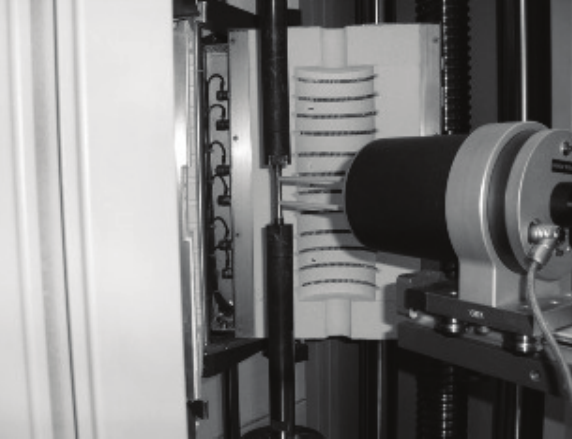
Figure 1. Experimental system (furnace and high tempera- ture